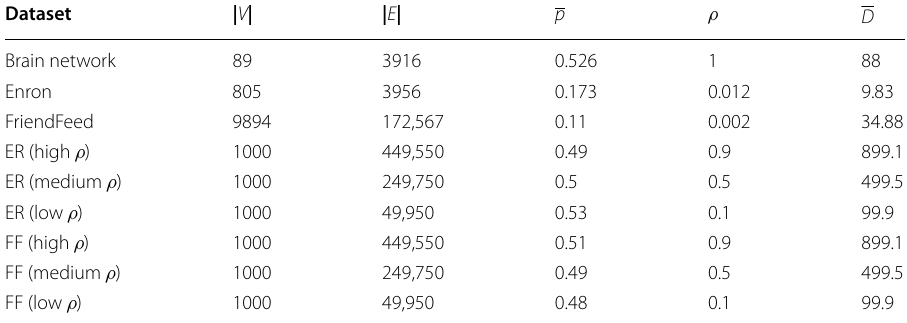
Table 2 Characteristics of datasets, | V | is the number of nodes, | E | is the number of edges, p is the mean of the edge probabilities, ρ = 2 | E | /( | V | ( | V | − 1 )) is graph density and D = 2 | E | / | V | is average degree (Lee et al. 2010)